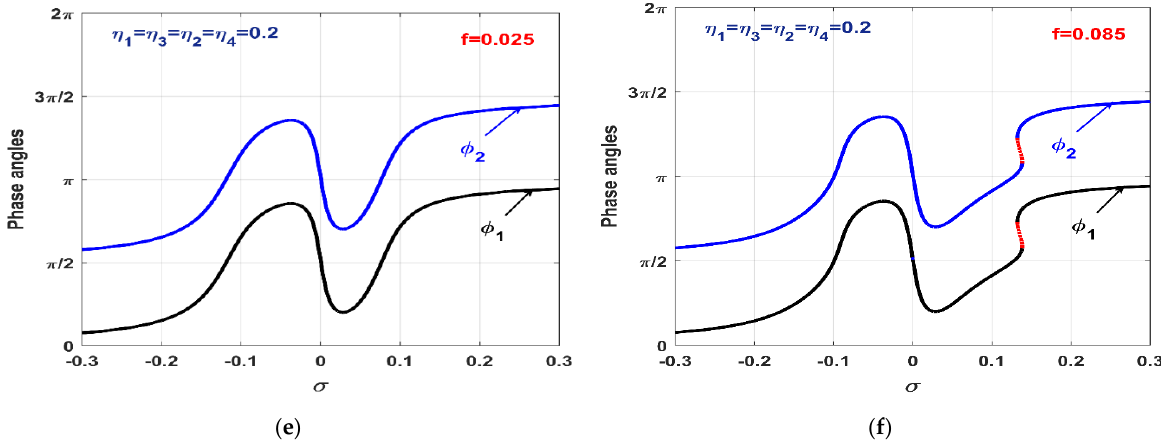
Figure 6. Vibration amplitudes of the twelve-poles rotor in the case of the PD + IRC + PPF -control algorithm when f = 0.025, 0.045, 0.065, and 0.085: ( a , b ) vibration amplitudes ( a 1 , a 2 ) of the rotor, ( c , d ) vibration amplitudes ( b 1 , b 2 ) of the PPF controller, ( e ) phase angles ( φ 1 , φ 2 ) when f = 0.025, and ( f ) phase angles ( φ 1 , φ 2 ) when f =